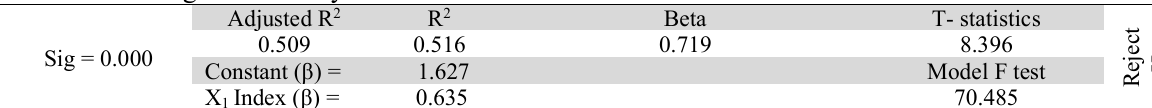
The results of regression